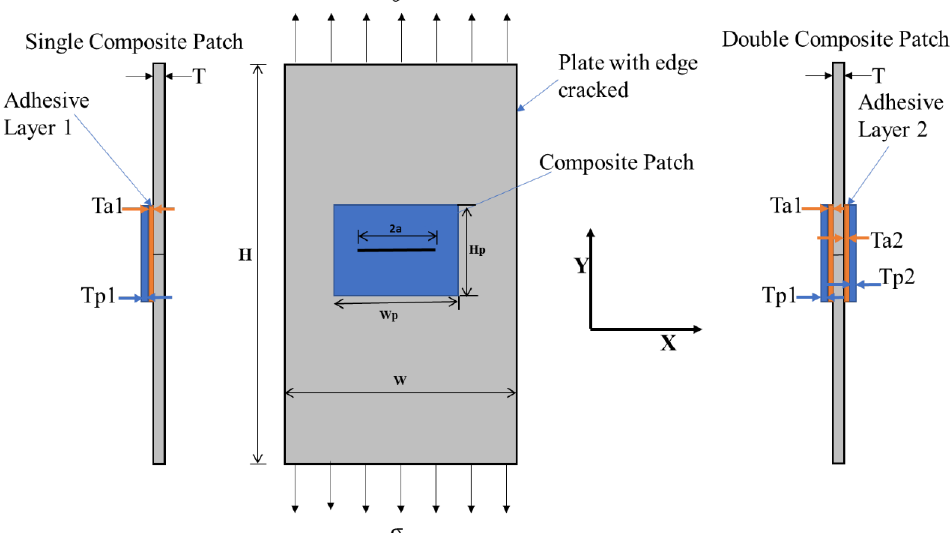
Figure 1. Rectangular plate through a center-cracked integrated composite patch.